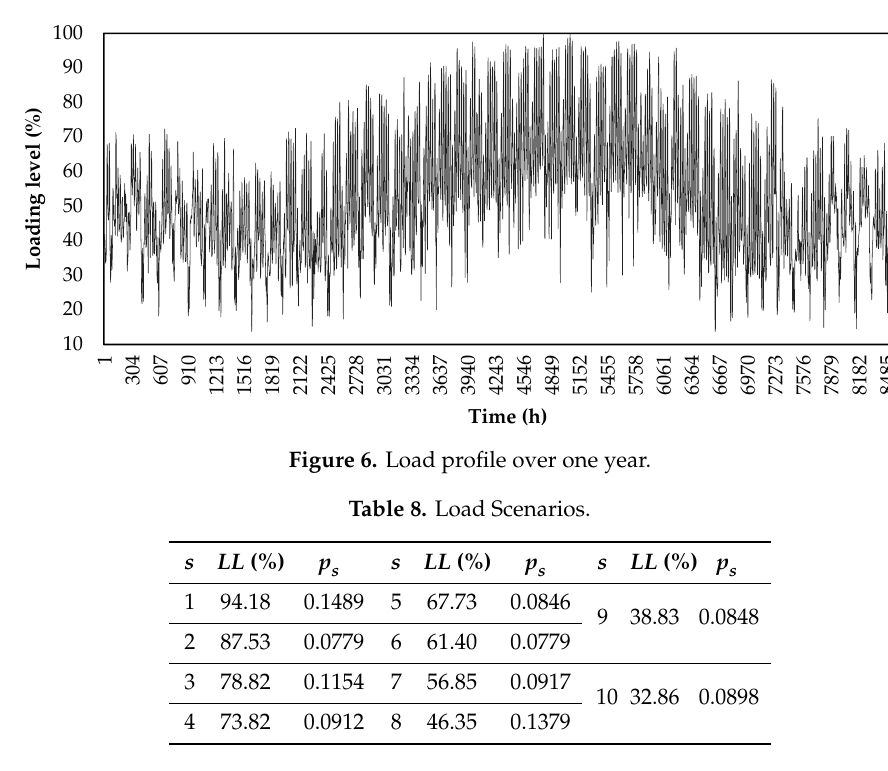
Figure 5. Voltage profile for the 83-node system in the deterministic case.